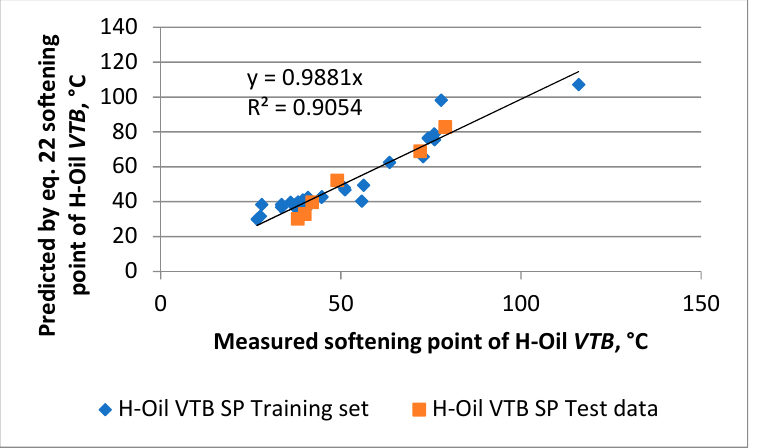
Figure 4. Agreement between measured and predicted viscosities of blends of 70%H-Oil VTB/30%FCC HCO for 33 training set points and 6 test set points using Equation (21).